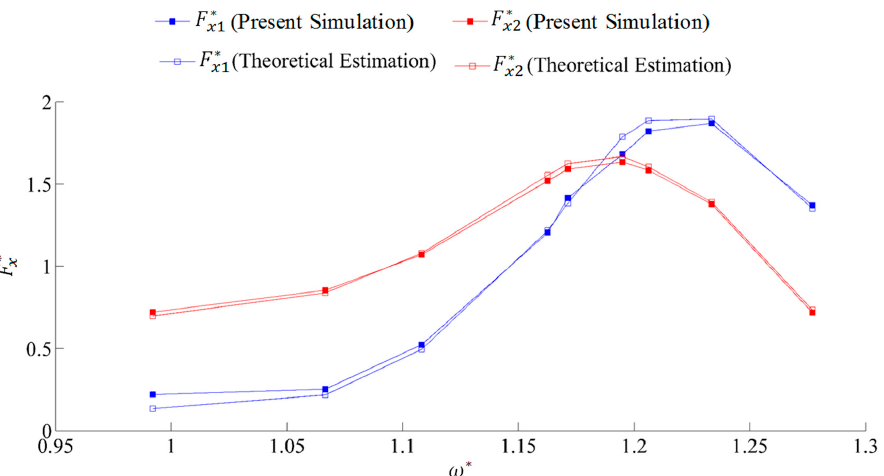
Figure 16. The horizontal forces F ∗ x estimated based on Equations (30) and (31) are in good agreements with the simulation results ( B ∗ g =